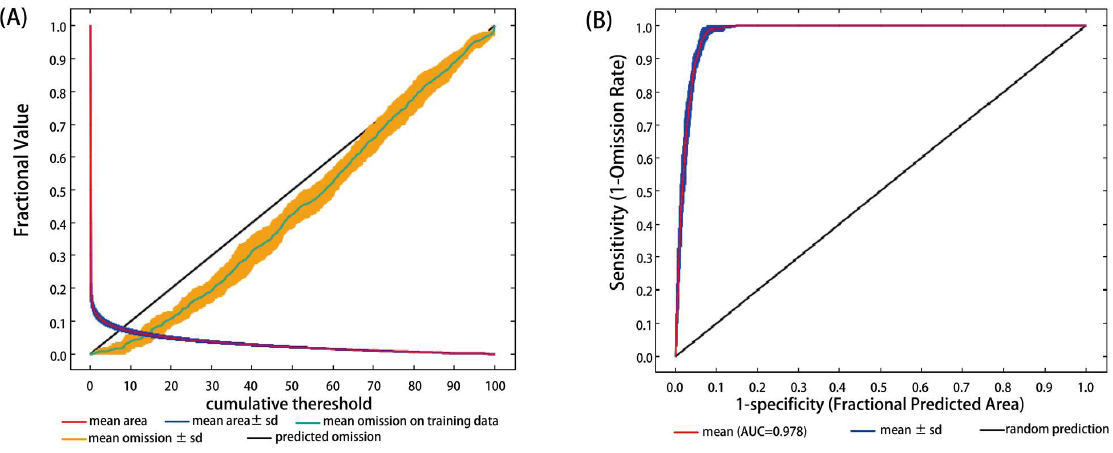
Figure 1. Validation charts of model performance. ( A ) Training omission rate graph; ( B ) receiver operating characteristic curve.